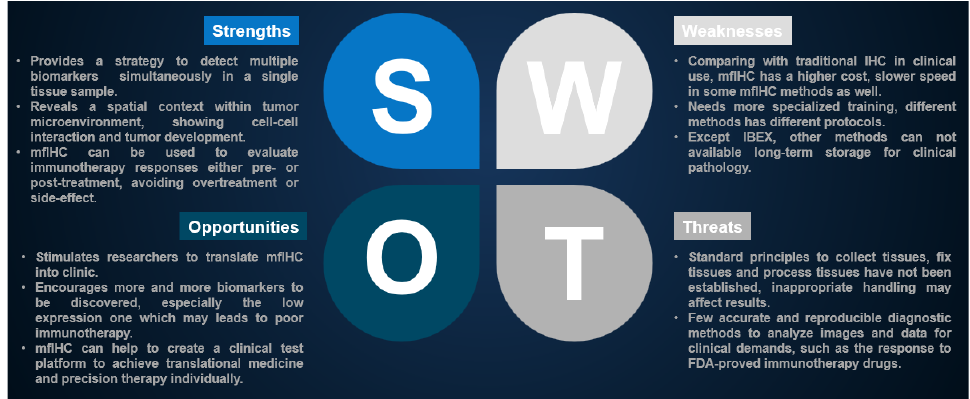
Figure 7. Strengths, Weaknesses, Opportunities, and Threats (SWOT) analysis regarding mfIHC applications in clinical cancer immunotherapy. Table 3. Advantages and disadvantages for different mfIHC technologies.